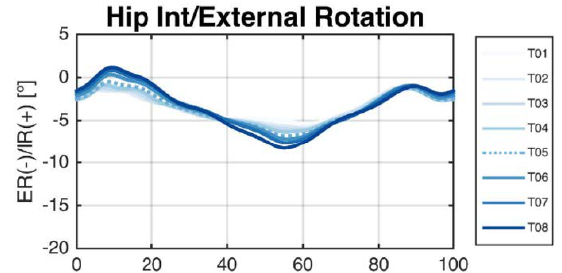
Fig. 5 Periodic extraction